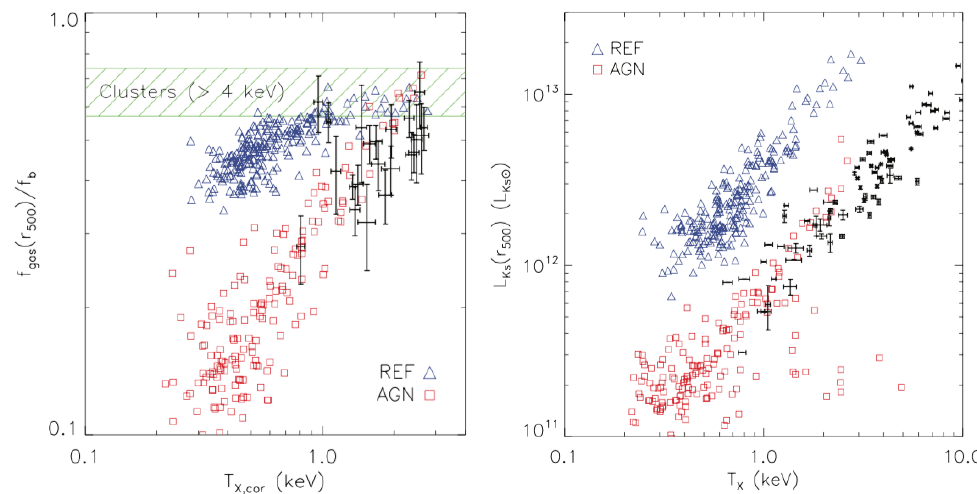
Figure 1. Figure panels adapted with permission from McCarthy et al. [132] showing OWLS simulations, with only stellar feedback (REF, blue triangles) and with additional AGN feedback (AGN, red squares). ( Left ) The AGN feedback provide a better fit to the Sun et al. [2] observationally derived f 500 data (black points) as a function of X-ray temperature; ( Right ) AGN feedback reduces the integrated K-band luminosity within R 500 to observable values compiled by Lin and Mohr